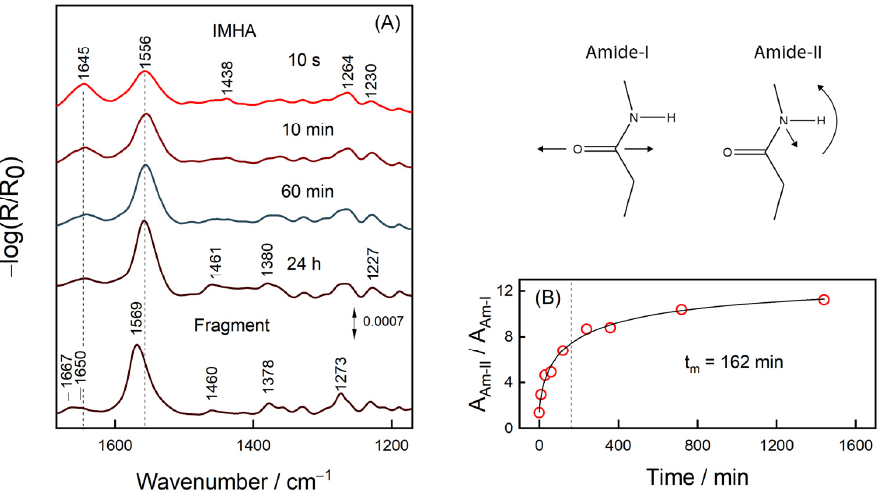
Figure 5. ( A ) The immersion time dependent RAIRS spectra of IMHA and the spectrum of the fragment molecule after 24 h-incubation. ( B ) Dependence of integral intensity ratio Am-II/Am-I on the immersion time fitted with the sigmoidal curve (R 2 = 0.9925). The transition midpoint at 162 min marked by a dashed line. Cartoon depicts the atom motions in Amide-I and Amide-II vibrations. Table 2. Wavenumbers and FWHM (bold) of Am-I and Am-II modes of IMHA and fragment molecule obtained from samples in powder form and